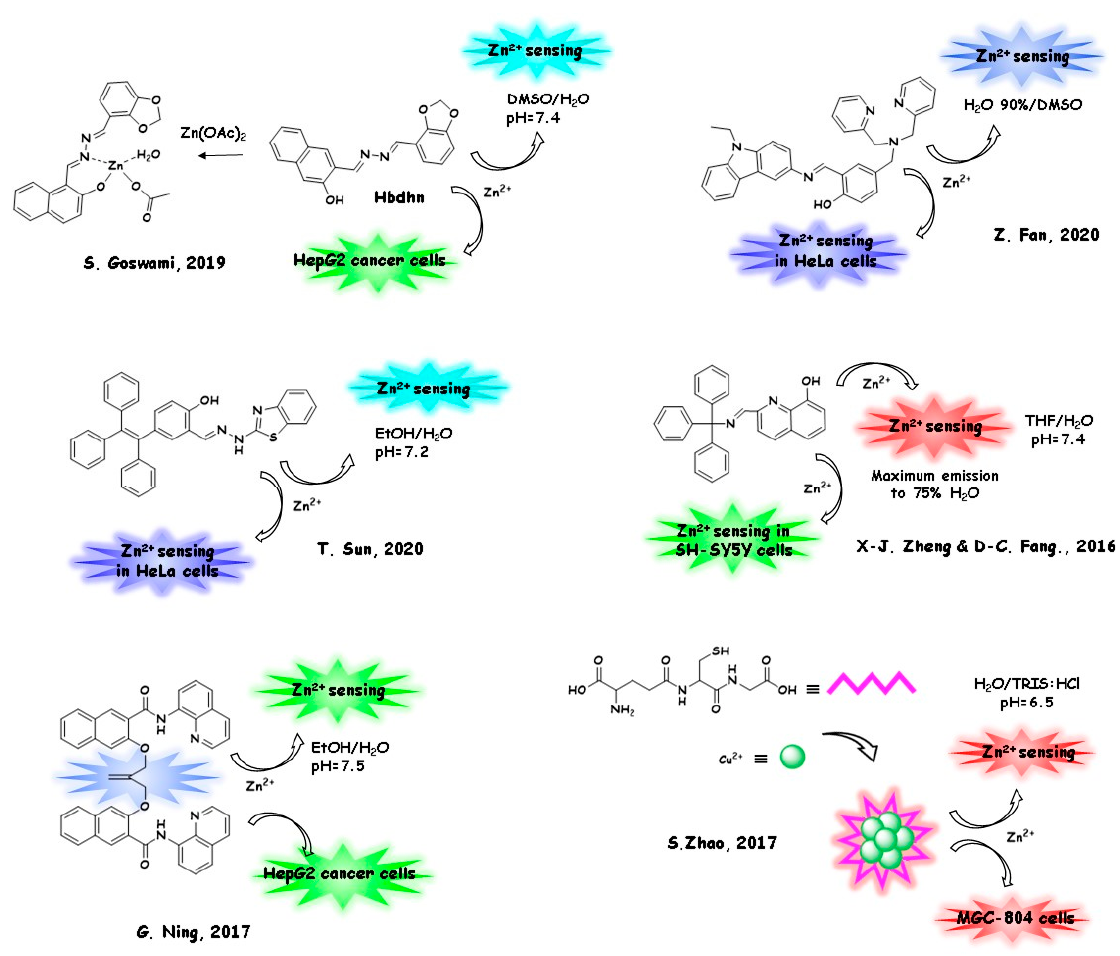
Figure 9. Structures and sensing/marking pattern of relevant AIEgens for zinc (II) detection in living cells.